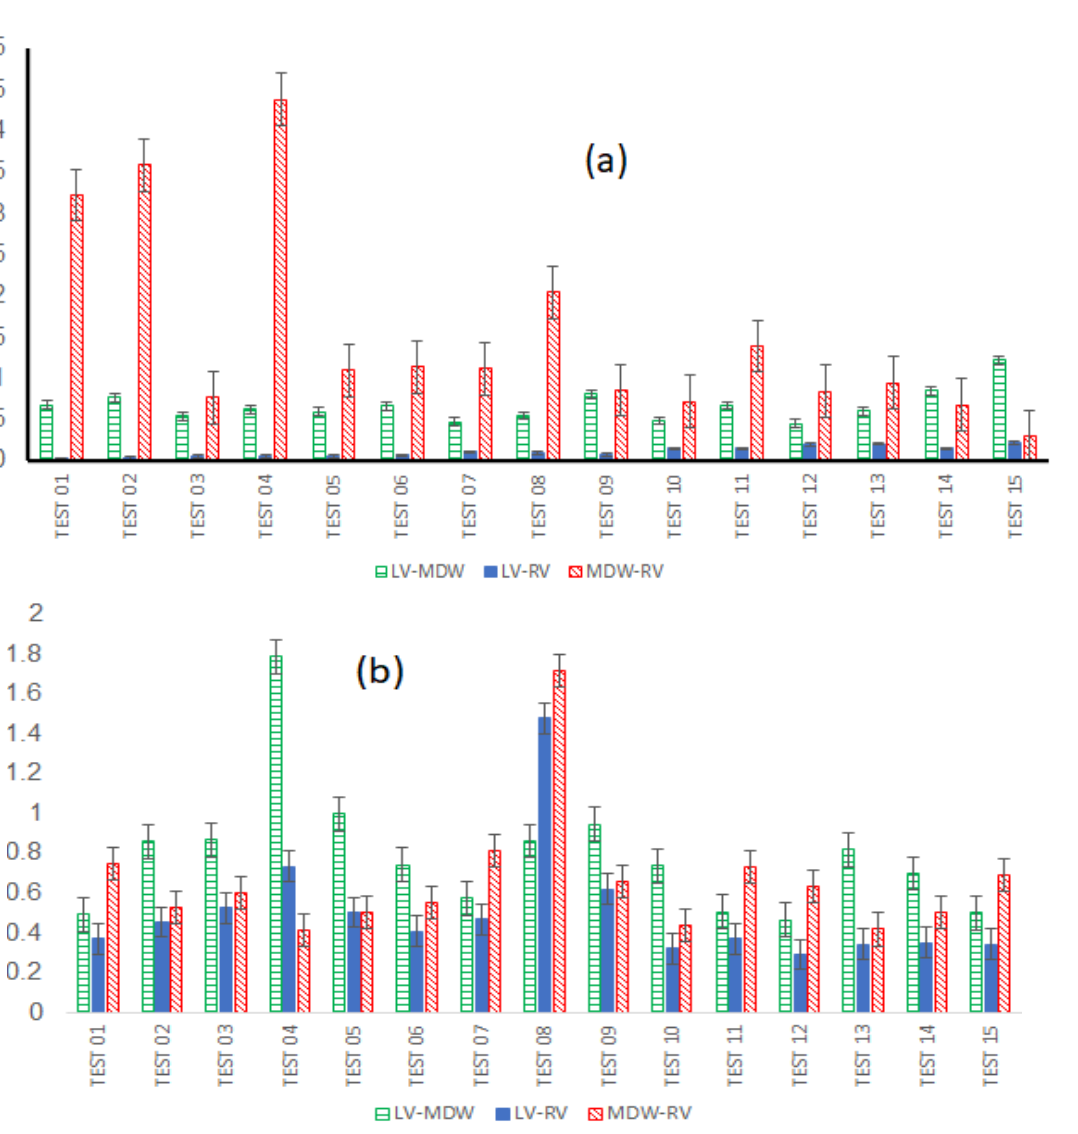
Figure 9. Ratios of elastic moduli across different walls for all fifteen tests described as cross-wall variations in ( a ) for longitudinal-to-longitudinal directions of each wall and ( b ) for circumferential-to-circumferential directions for each wall.